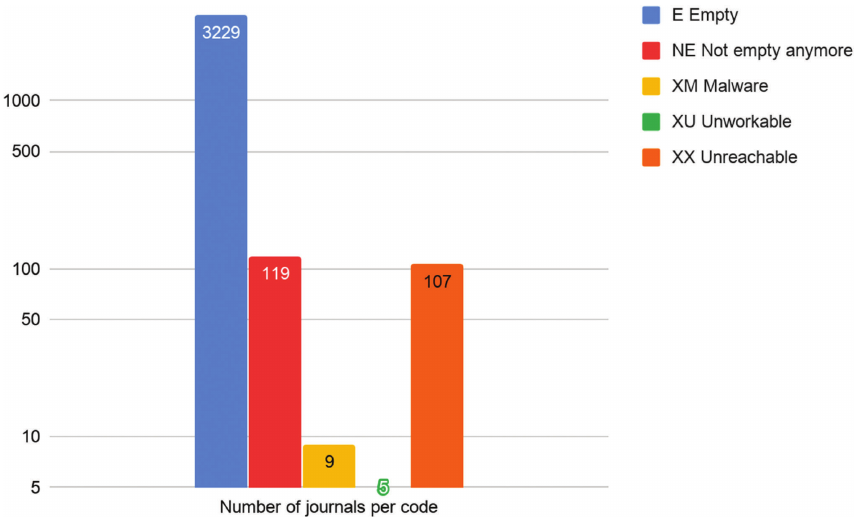
Fig. 2: New code distribution of the 3,469 journals originally tagged as empty by Crawford that we observed included in Cabell’s